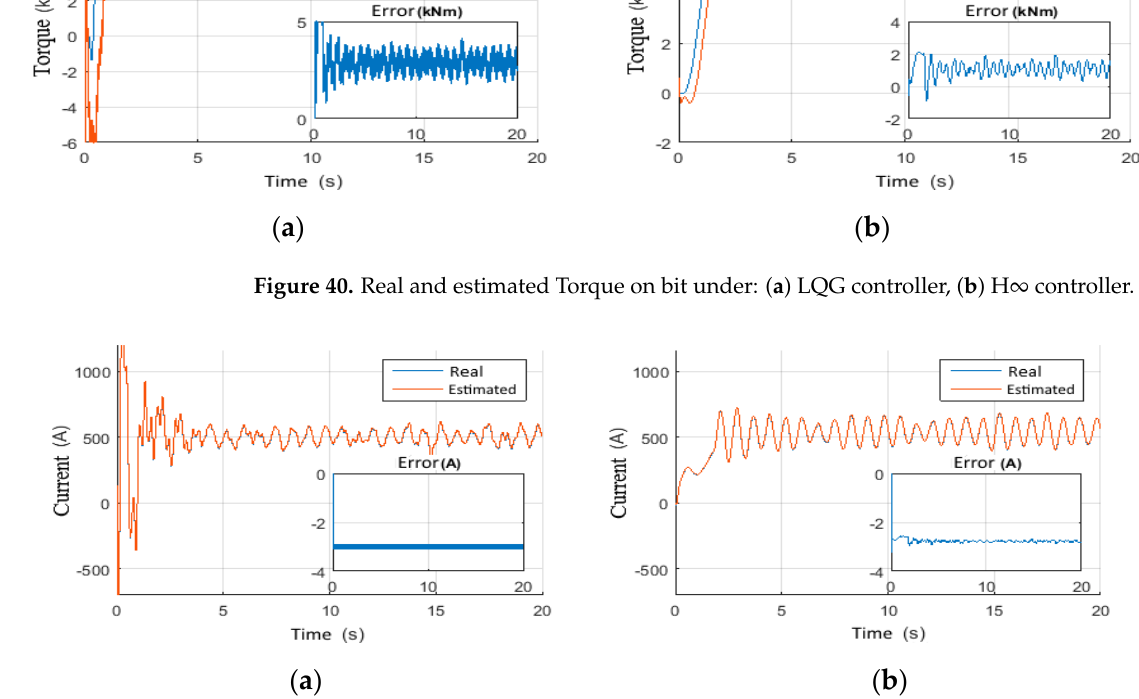
Figure 41. Real and estimated Top drive current under: ( a ) LQG controller, ( b ) H ∞ controller.